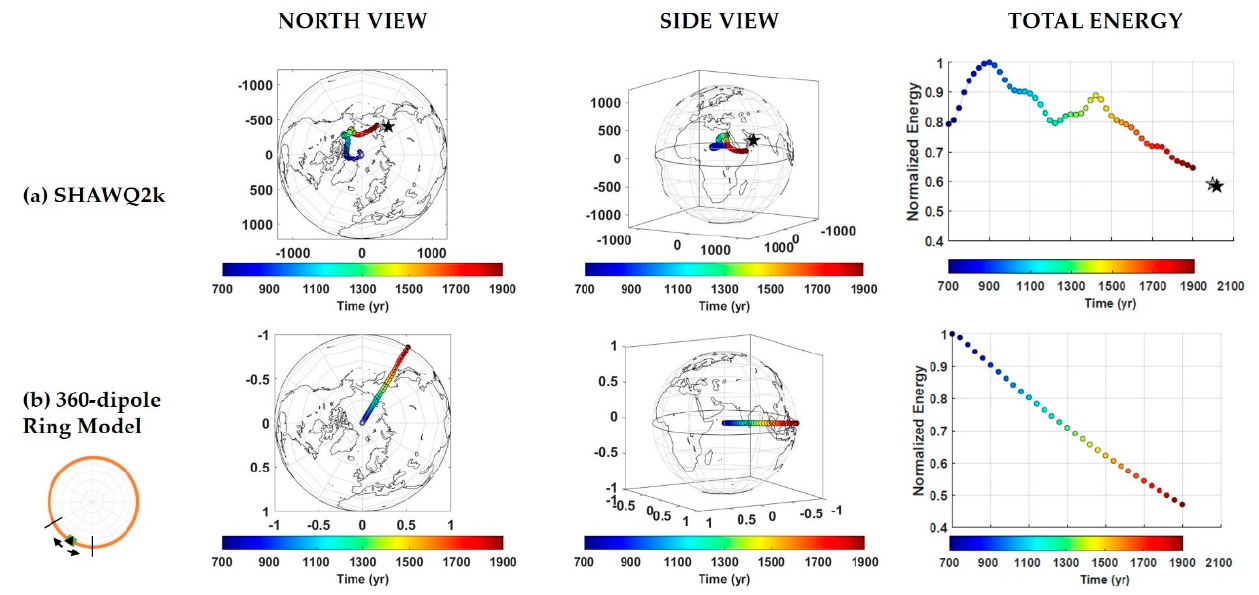
Figure 5. Evolution of the ED and the normalized total energy for the South Atlantic Anomaly period according to ( a ) the SHAWQ2k paleoreconstruction (position in km) and ( b ) the 360-DRM proposed in this paper, reversing and multiplying of the dipoles between 300° E and 0° E. Gray and black stars correspond to the ED location at 2000 and 2020 AD, respectively, calculated with the IGRF-13. Orange/green circumference indicates the dipoles that change their polarity (the first one is marked with a black triangle), the propagation directions (black arrows), and the limits of the reversing regions (black lines). Note that in ( b ) the evolution of the ED is dimensionless. Coastlines are plotted only for longitude reference (note they are projected on a sphere of arbitrary radius).